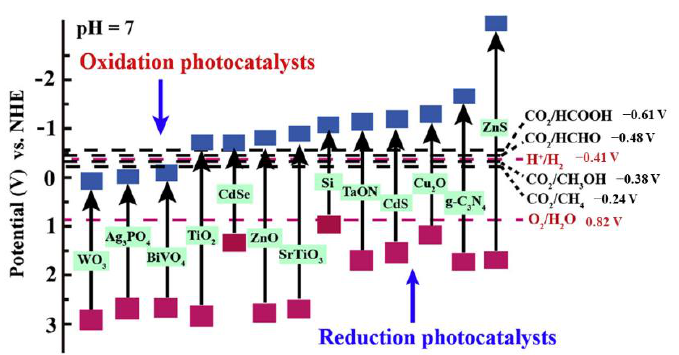
Figure 1. Band structures of some representative photocatalysts. Reprinted with permission from Ref. [46]. 2020 Xu, Q.; Zhang, L.; Cheng, B.; Fan, J.; Yu, J.